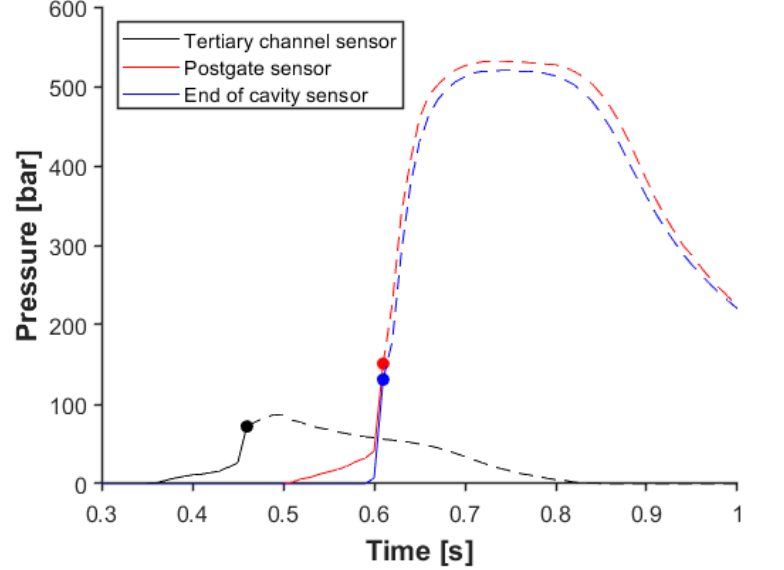
Figure 5. The effect of sensor location on switchover pressure (sensors from the flow path to cavity 02). Generally, the desired transition between the filling and holding stage is such that there is no sudden significant change in pressure due to the switchover point. This means that after the cavity is filled, there is a short time when the melt is compressed during filling. After that, when holding pressure is applied, the additional melt is pushed into the cavity to decrease the shrinkage of the product. If the pressure drops during this transition, it means that too much pressure is applied during filling or the holding pressure is insufficient. In the former case, the mold may open (if the clamping force is not high enough), and a flash can appear at the side of the product. If injection pressure is too low, the product will contain sink marks due to the lack of material in the thicker parts of the product. To get a smooth switchover on the pressure curve, we examined the effect of switchover pressure on the data obtained with the sensor installed at the tertiary runner. Figure 6 shows how in-mold pressure changes when the pressure trigger is 50 bar, 100 bar, 125 bar, or 150 bar. With a 50-bar trigger level, the melt did not reach the cavity; in the case of 100 bar, the melt reached the end of the cavity sensor. However, the pressure in the cavity was below 70 bar, which means the cavity was only filled, but there was no compression during the filling stage. In the case of a 125-bar or 150-bar trigger, we found that in-mold pressure increased significantly after the SWOP, even though we did not apply holding pressure. This phenomenon is most probably caused by the accumulated melt in the runner system.